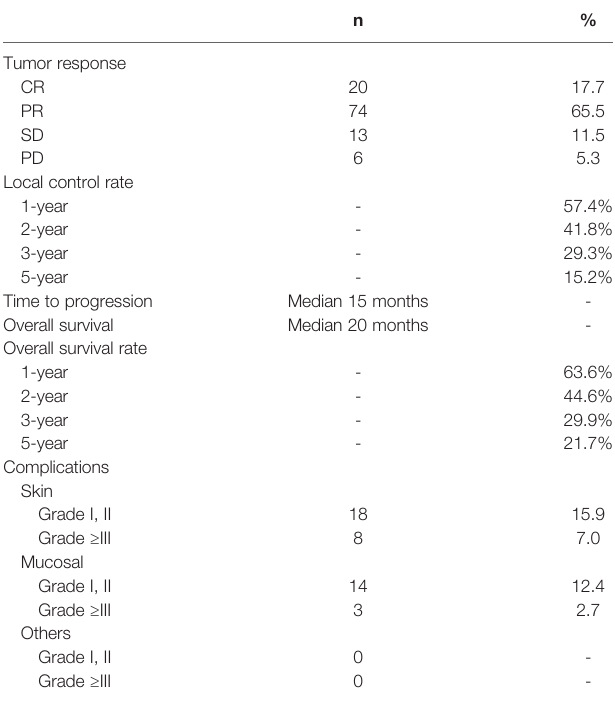
TABLE 2 | Clinical outcomes of the 113 patients.